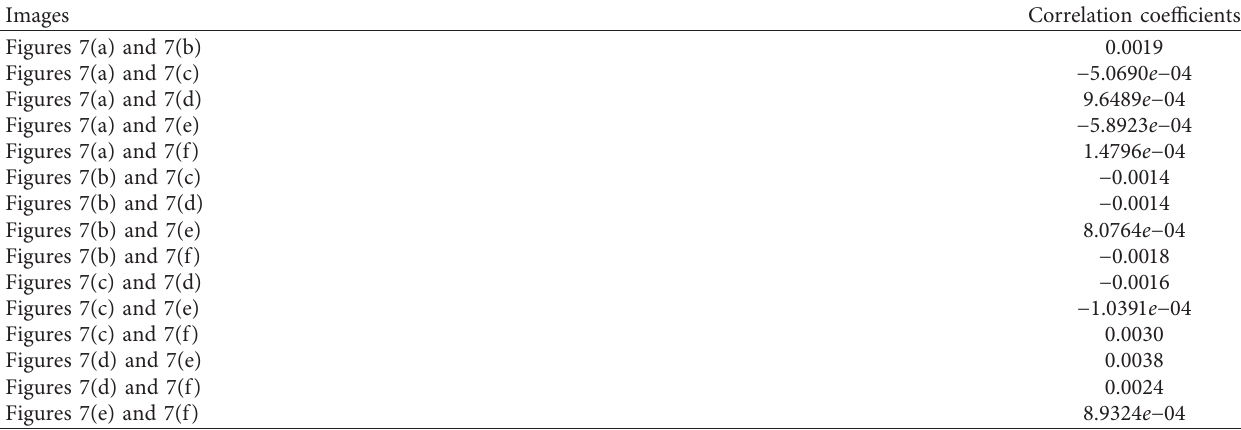
Figure 8: (a and b) The plain image from “ultrasound of fetus of 3 months” image and its corresponding encrypted image. (c)-(f) The decrypted images from the encrypted image of Figure 8(b) using slightly different decryption keys than the key used for encryption. Table 8: Correlation coefficients between various decrypted images shown in Figure 8.